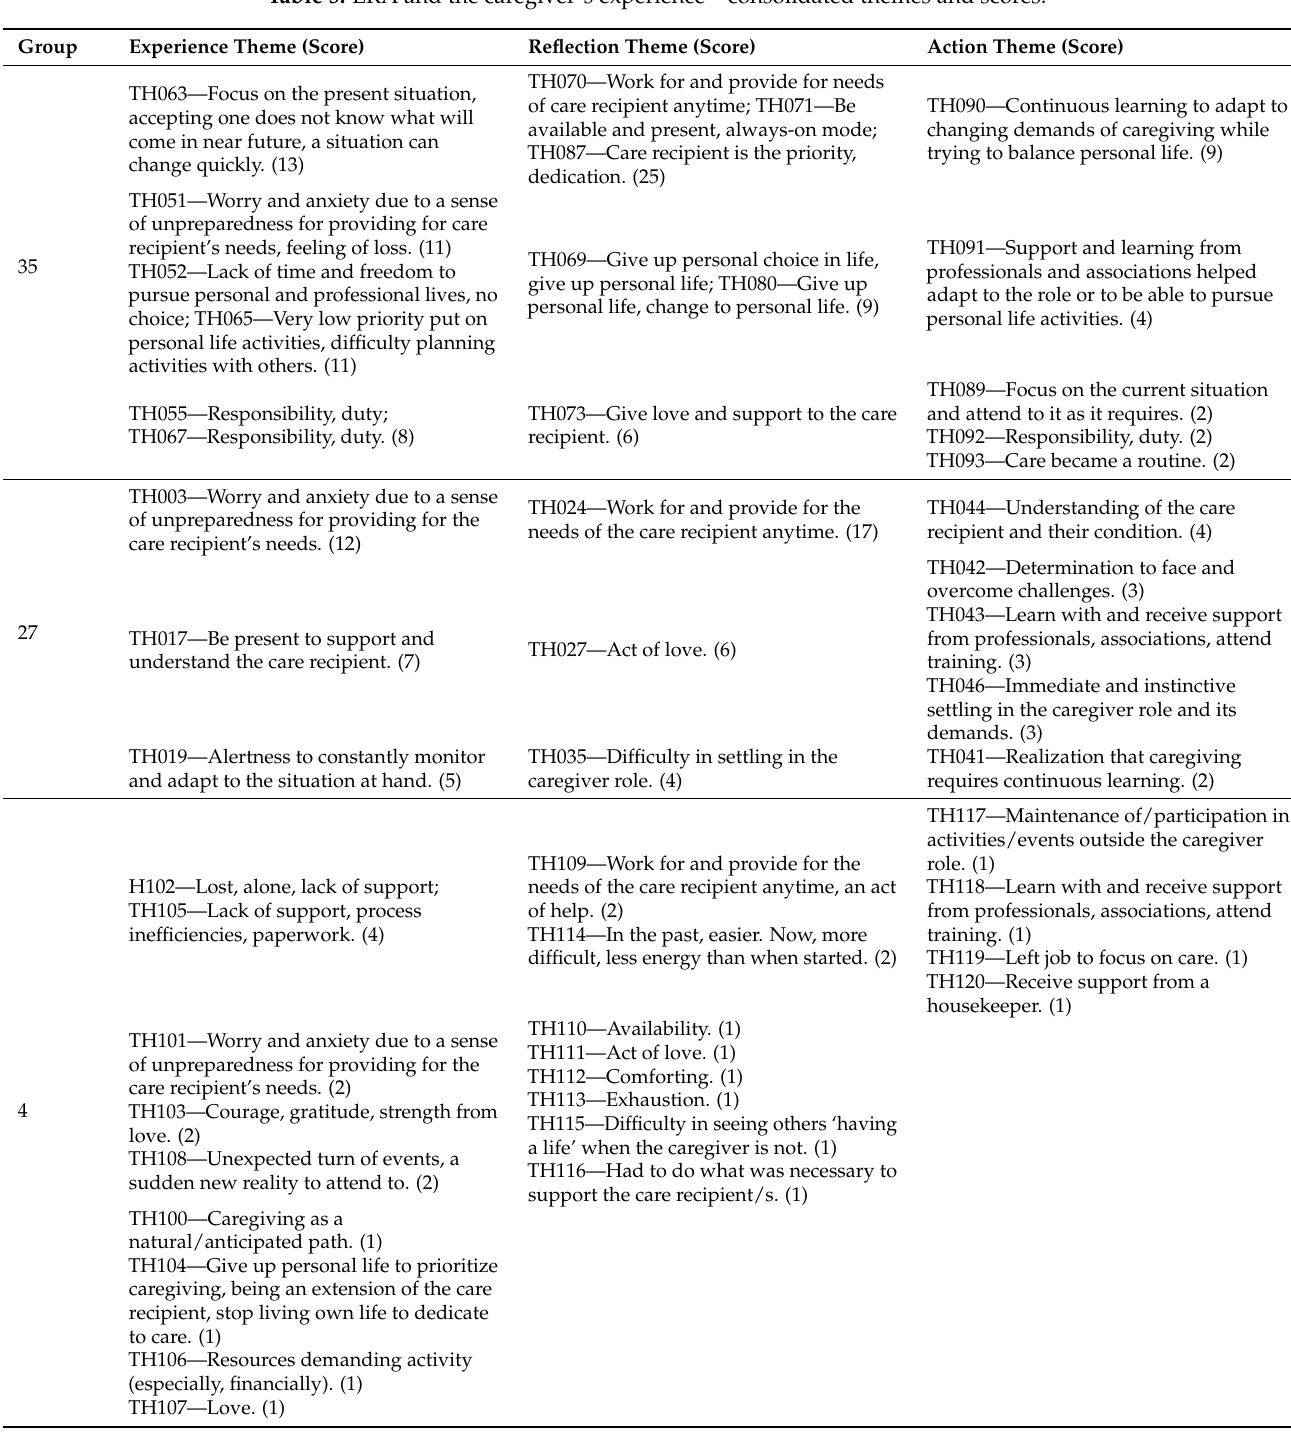
Table 5. ERA and the caregiver’s experience—consolidated themes and